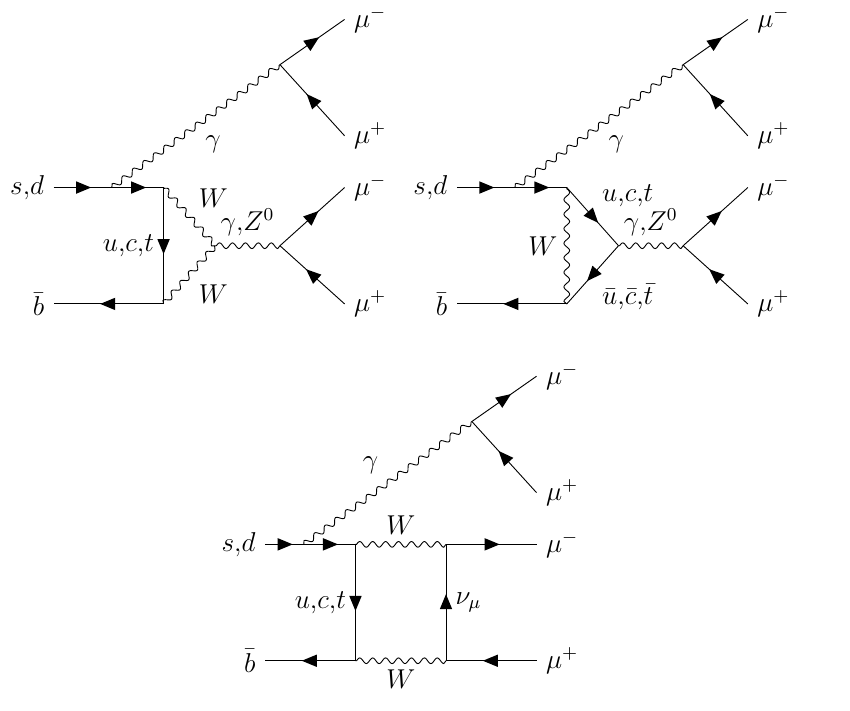
Figure 2: Feynman diagrams for the non-resonant decay. Figure 1 . Feynman diagrams for nonresonant B 0